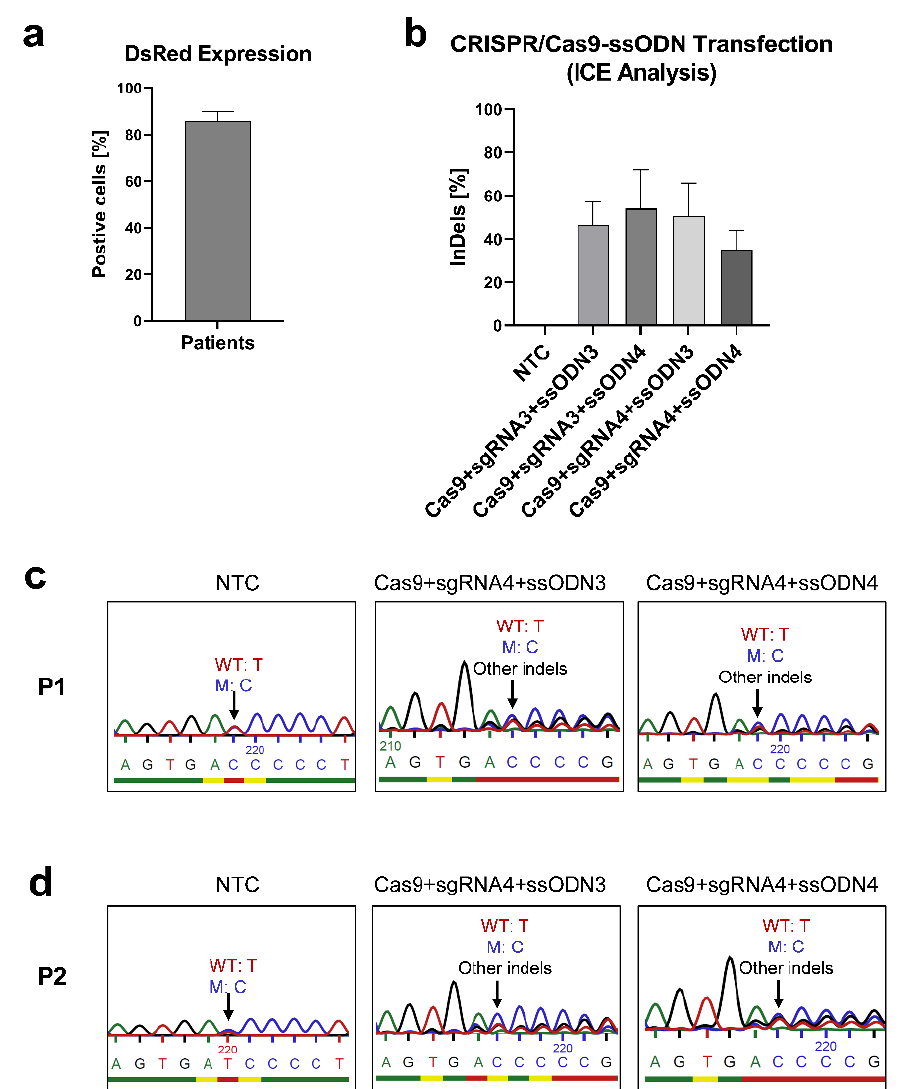
Figure 4. CRISPR/Cas9-ssODN transfection in mosaic T cells to correct the IL2RG c.458T>C mutation. T cells of patients (n = 2, P1 and P2) were transfected with RNP ( IL2RG sgRNA3/4 and Cas9)- ssODN3/4 to correct the c.458T>C IL2RG mutation with MaxCyte ® . ( a ) DsRed mRNA was expressed in up to 90% of cells. ( b ) The indel frequency of edited samples with different RNPs and ssODNs was 26–72%. Mean ± SEM of biologically independent experiments is shown. The Sanger sequencing of non-transfected and transfected T cells with the Cas9, sgRNA4, and ssODN3/4 T cells of ( c ) P1 and ( d ) P2. (The blue, red, green, and black peaks stand in place of bases C, T, A, and G respectively). Compared with the unedited cells, the indel generation was visible, but no higher frequency of the wild-type nucleotide was observed in the edited samples.